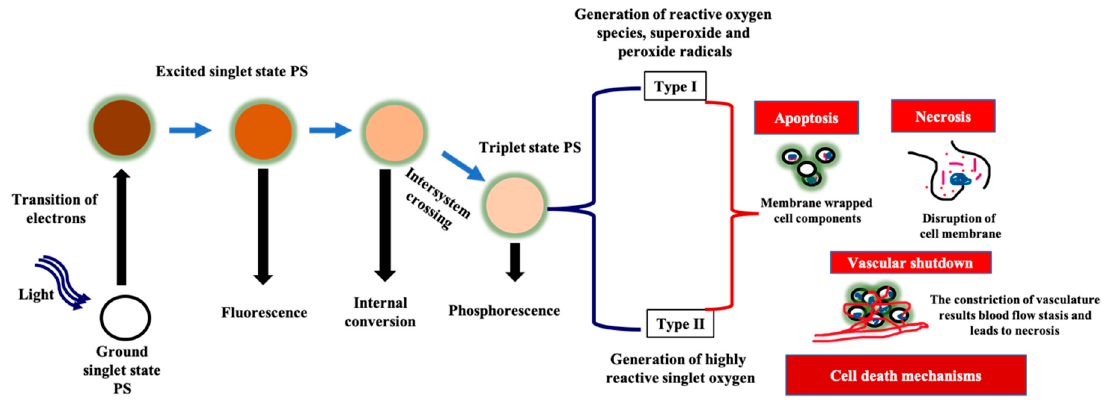
Figure 1. The general mechanism of photodynamic therapy.